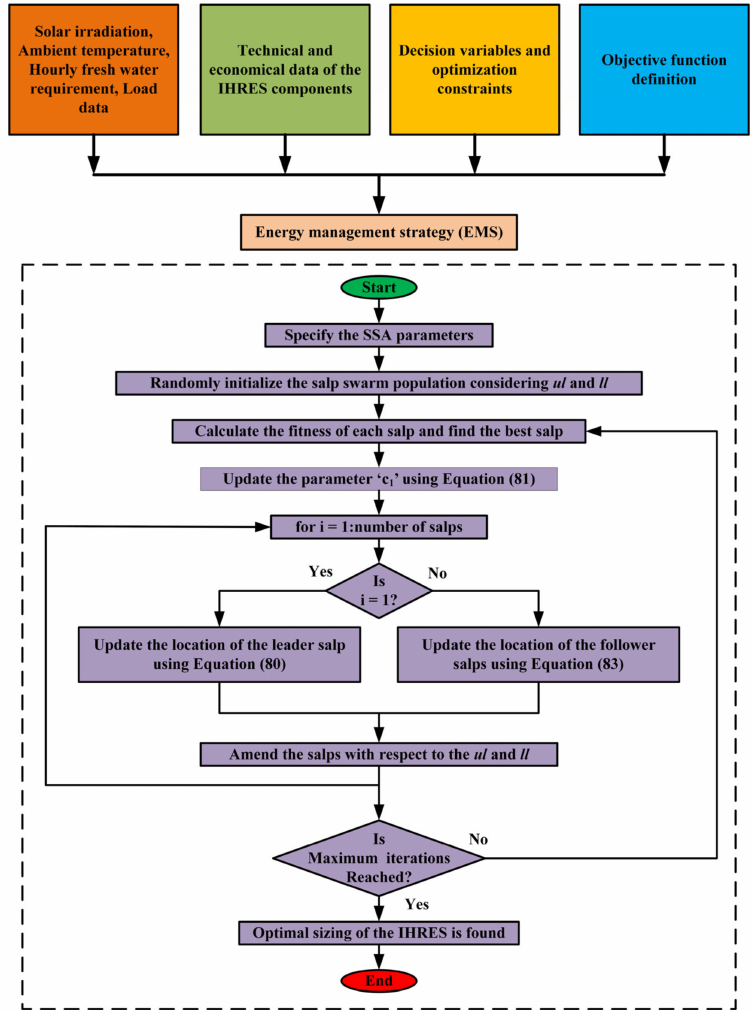
Figure 15. Flowchart illustrating the procedure for evaluating the optimal IRES sizing with